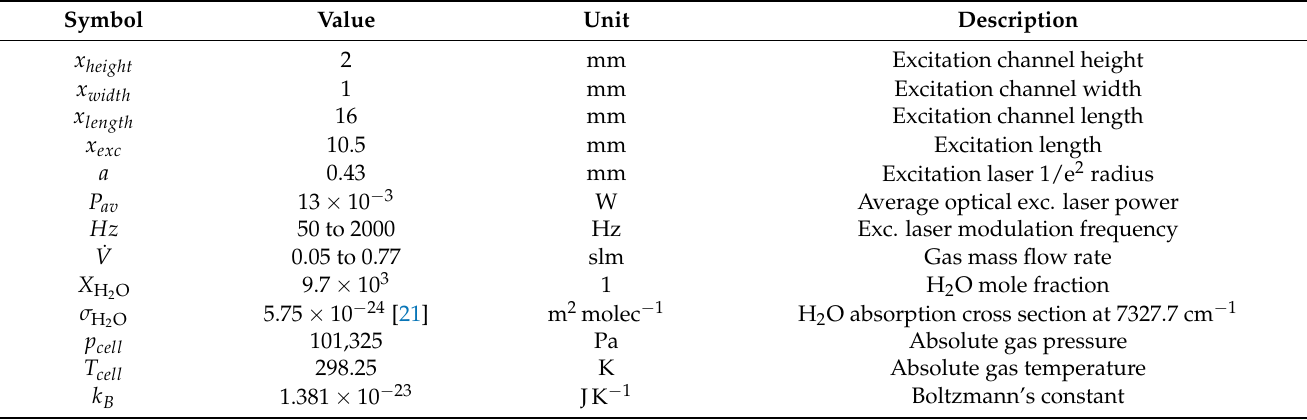
Table A1. Listing of the primary parameters for the calculation of the theoretical temperature amplitude ∆ T